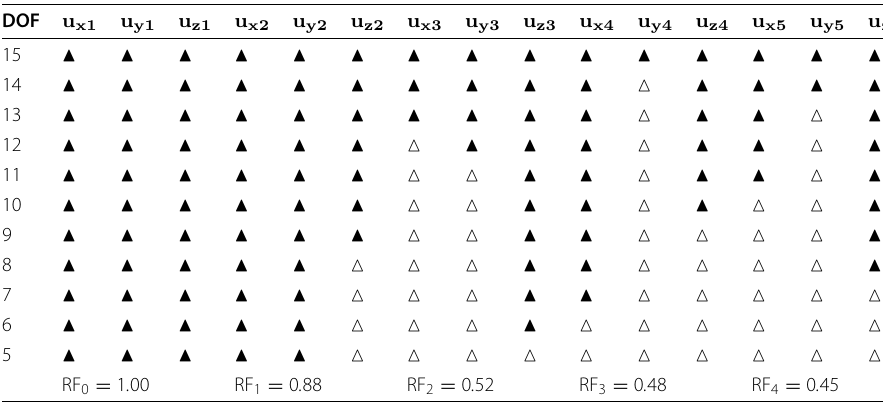
Fig. 8 FE and NN results for 0/90/0, a/h = 50, one layer with ten neurons Table 7 BTD models, 0/90/0, a/h =